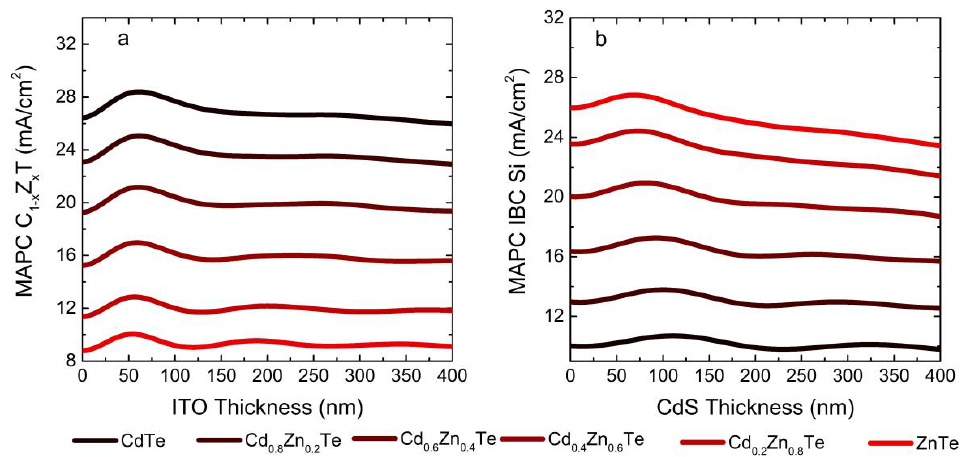
Figure 4 Figure 4. The MAPC of C 1 − x Z x T ( a ) and IBC Si ( b ) cells for various x values and C 1 − x Z x T thickness